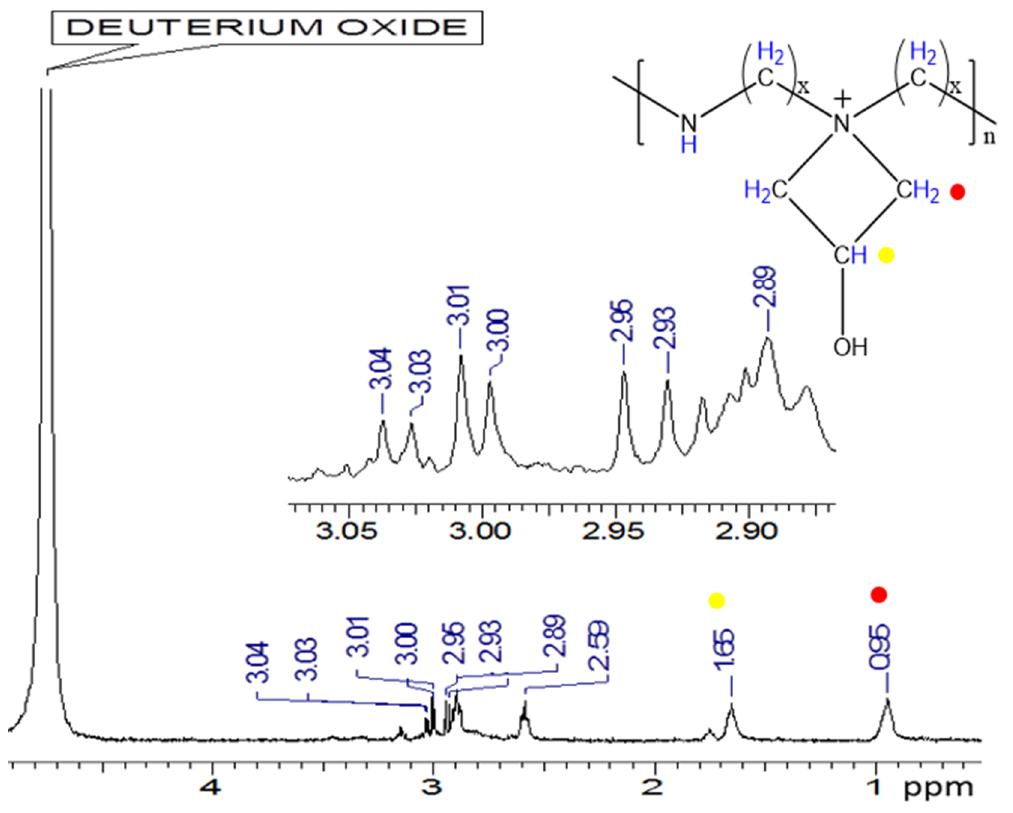
Figure 4. Nuclear magnetic resonance ( 1 H-NMR) spectrum of the polyamine (Polycoat 38 ® ) resin